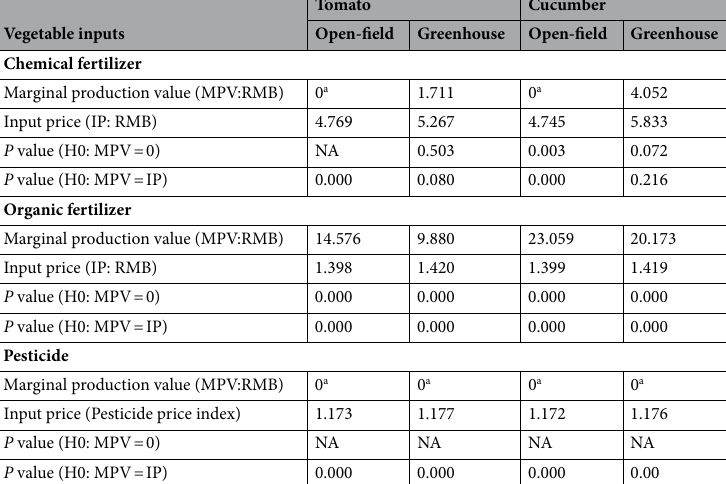
Table 3. Marginal product values and the prices of fertilizer and pesticide. One more unit of agrochemical does not produce any vegetables. NA refers to no value. a The input does not significantly affects the output, therefore, the MPV is